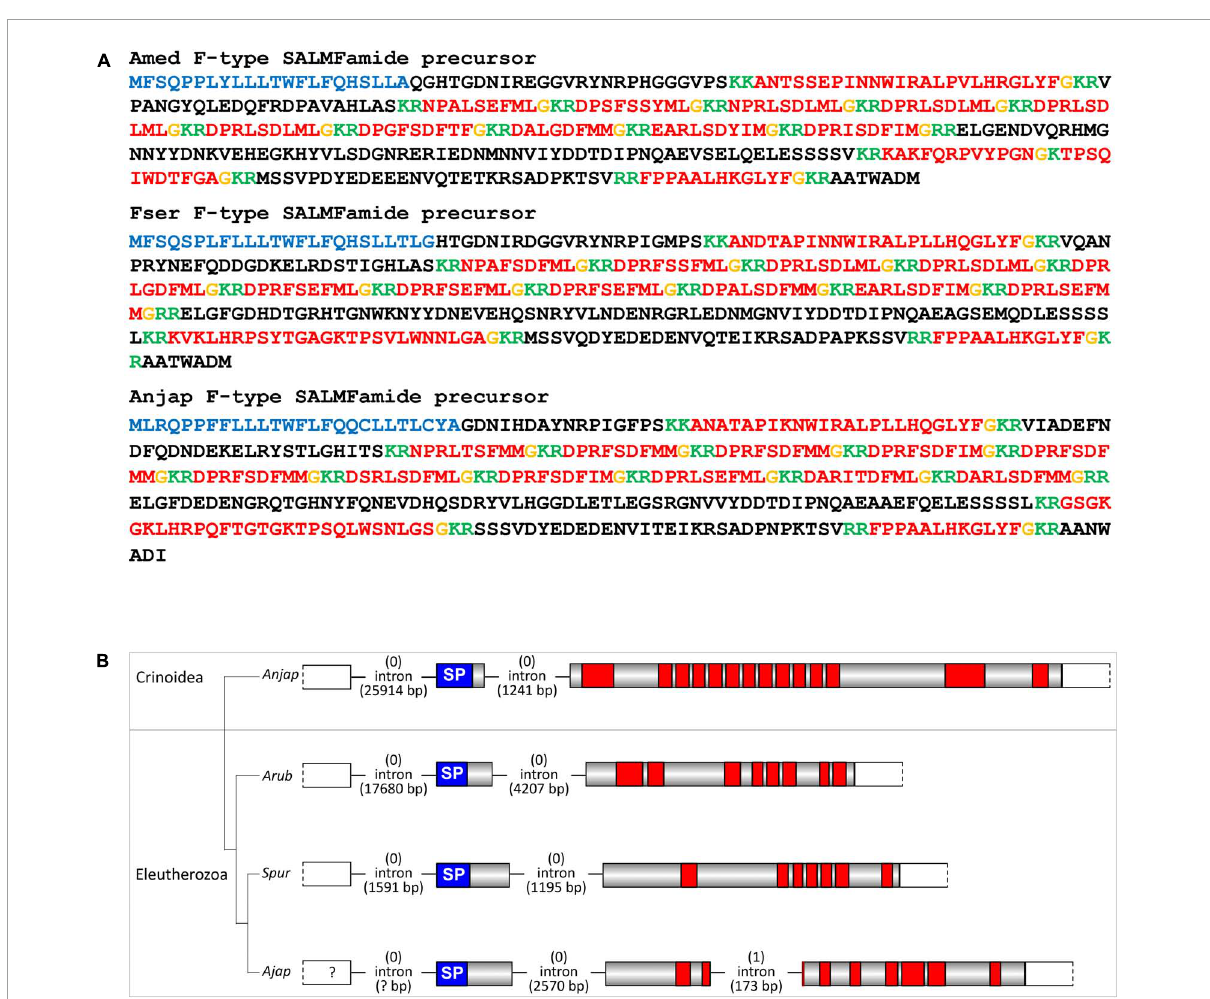
FIGURE6 Crinoid F-type SALMFamide precursors and comparison of gene structure with eleutherozoan F-type SALMFamide precursor genes. (A) Sequences of F-type SALMFamide precursors in three crinoid species, Antedon mediterranea (Amed), Florometra serratissima (Fser), and Anneissia japonica (Anjap). The predicted signal peptide is shown in blue, predicted monobasic/dibasic cleavage sites are shown in green and predicted neuropeptides are shown in red, but with C-terminal glycine residues that are potential substrates for post-translational amidation shown in orange. (B) Structure of the F-type SALMFamide precursor gene in the crinoid Anneissia japonica (Anjap) compared with the structures of F-type SALMFamide precursor genes in eleutherozoans, including the starfish Asterias rubens (Arub), the sea urchin Strongylocentrotus purpuratus (Spur), and the sea cucumber Apostichopus japonicus (Ajap). In all four species there are two phase 0 introns, with one preceding the start codon encoding the first methionine of the signal peptide and another located between an exon encoding the signal peptide and an exon or exons encoding the SALMFamide neuropeptides, which provides additional evidence that these genes are orthologs. The A. japonicus gene also has a second intron in phase 1 that interrupts the coding sequence for the second predicted SALMFamide